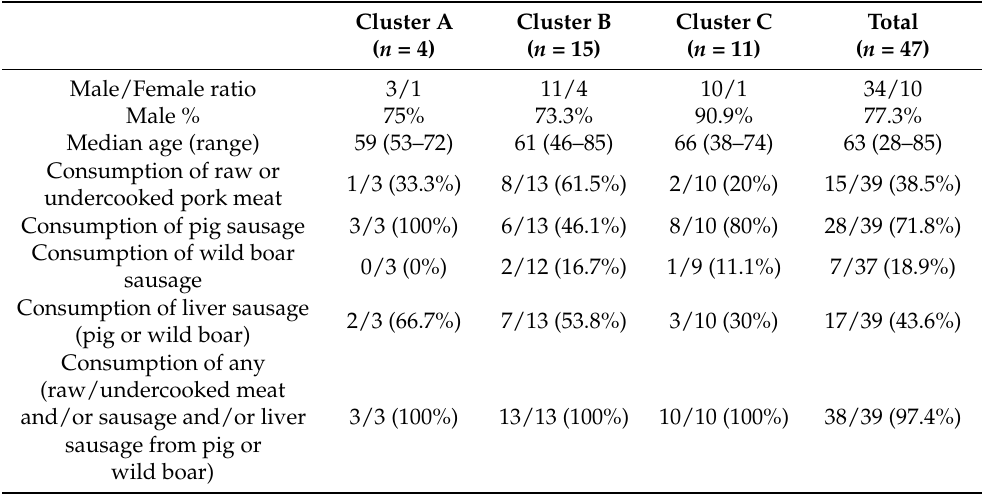
Table 1. Gender, age and risk factors of Cluster A, B, and C cases and 47 total cases of HEV infection with onset from 8 June to 6 December